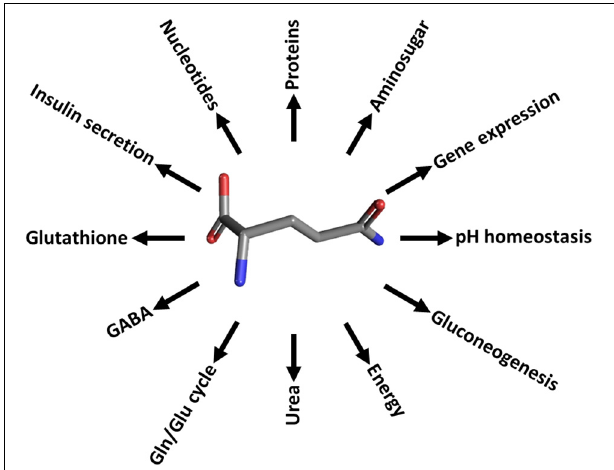
FIGURE 1 | The glutamine roles in cell pathways. Schematic representation of the cell processes involving glutamine. Proteins, protein synthesis; Aminosugar, aminosugar synthesis; Nucleotides, purine and pyrimidine synthesis; pH homeostasis, mainteinance of acid-base balance; Gluconeogenesis, precursor synthesis; Energy, providing carbon atoms for TCA; Urea, release of NH 3 in liver for urea synthesis; Gln/Glu cycle and GABA, neurotransmission regulation; Glutathione, GSH synthesis and redox balance regulation; Insulin secretion, glucose concentration regulation; Gene expression, gene expression